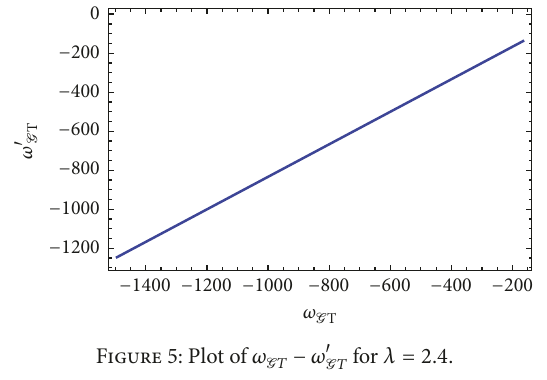
Figure 5: Plot of 𝜔 G 𝑇 − 𝜔 󸀠 G 𝑇 for 𝜆 = 2.4